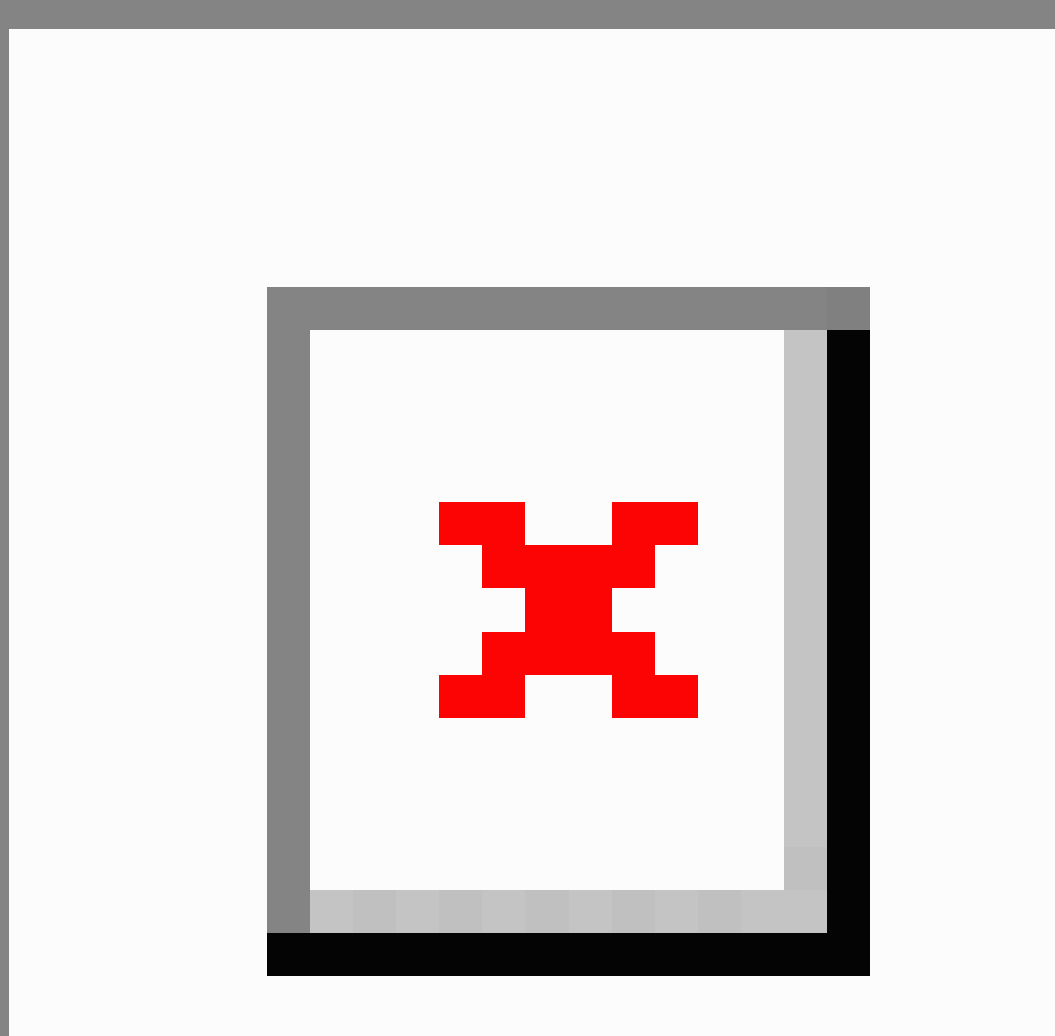
Figure 2. Screenshot captured from the PRO-based overview accessed from the EHR of the Central Denmark Region. The color codes in the upper row indicate the result of the automated PRO algorithm (red: definite need of contact; yellow: possible need of contact; green: no need of contact). Labels were translated from